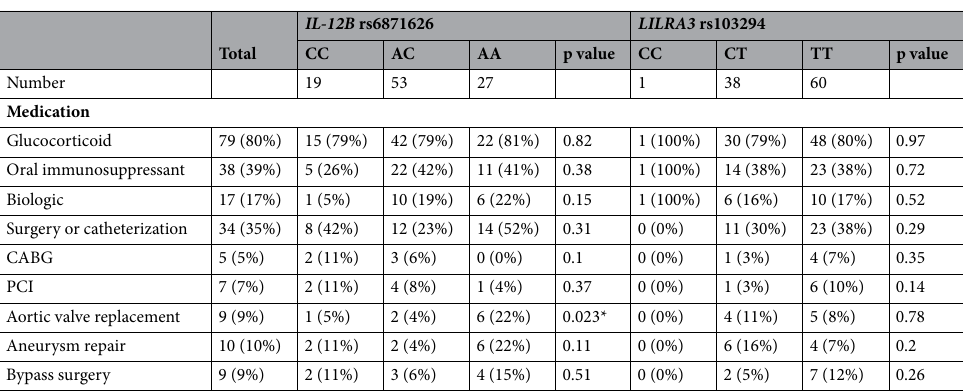
Table 2. Treatment profiles of the subjects. CABG coronary artery bypass grafting, PCI percutaneous coronary intervention. Data are n (%) or mean ± standard